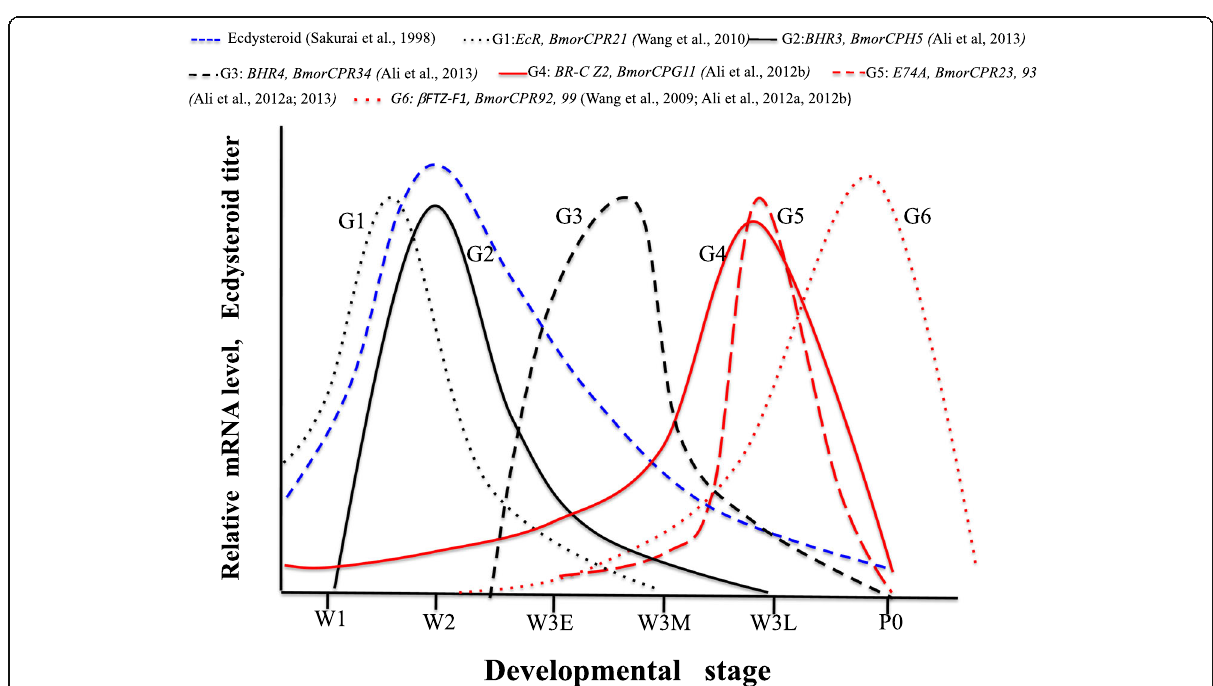
Fig. 1 Schematic representation of cuticular protein genes and related ecdysone-responsive transcription factors in parentheses expressed in wing discs of B. mori in the late fifth larval instar. Ecdysteroid titer (Sakurai, Kaya, & Satake, 1998), BmorCPR21 (Wang, Iwanaga, & Kawasaki, 2009), BmorCPR92 (Wang, Nita, et al., 2009), BmorCPR99 , BmorCPH5 , BmorCPR93 (Ali, Iwanaga, & Kawasaki, 2012) and BmorCPG11 (Ali, Wang, Iwanaga, & Kawasaki, 2012) are